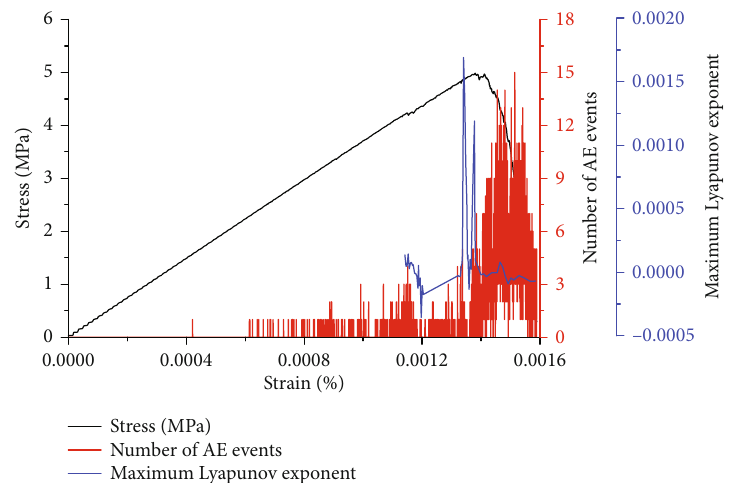
Figure 4: Stress-strain-number of AE events-maximum Lyapunov exponential variation diagram of specimen 1.